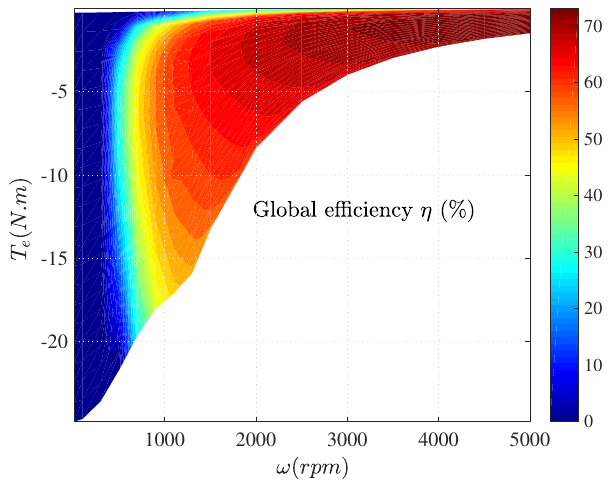
Figure 11. Drive